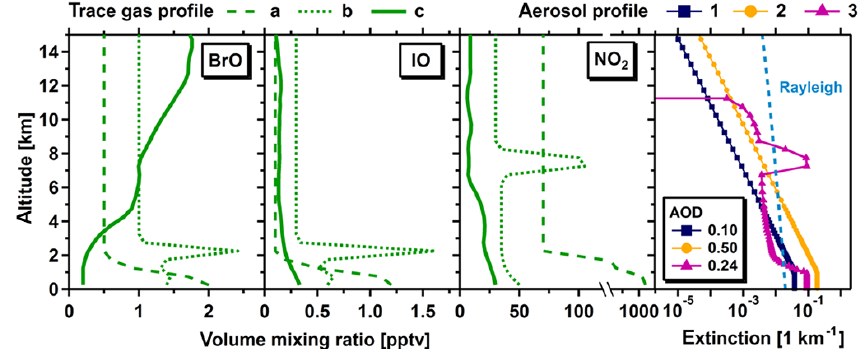
Figure 3. Trace gas volume mixing ratio and aerosol extinction profiles used to simulate dSCD data for sensitivity